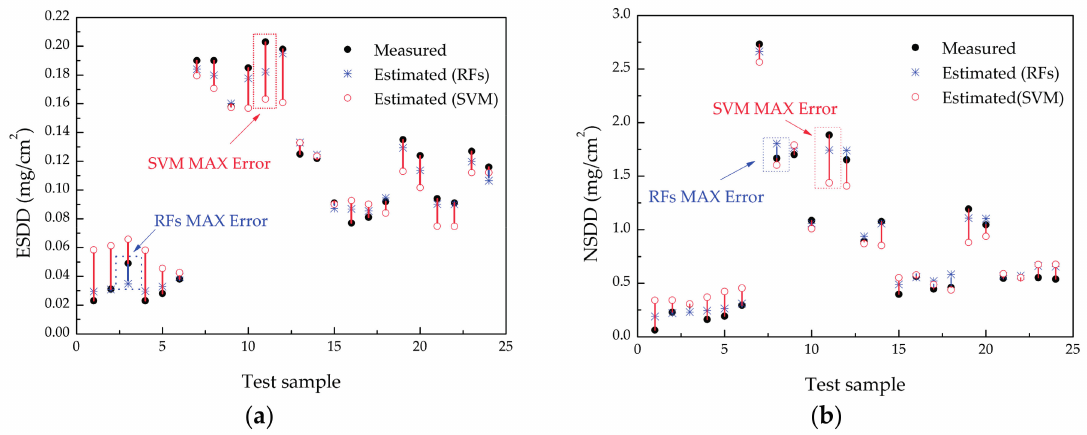
Figure 6. Contamination particle size. ( a ) ESDD; ( b )